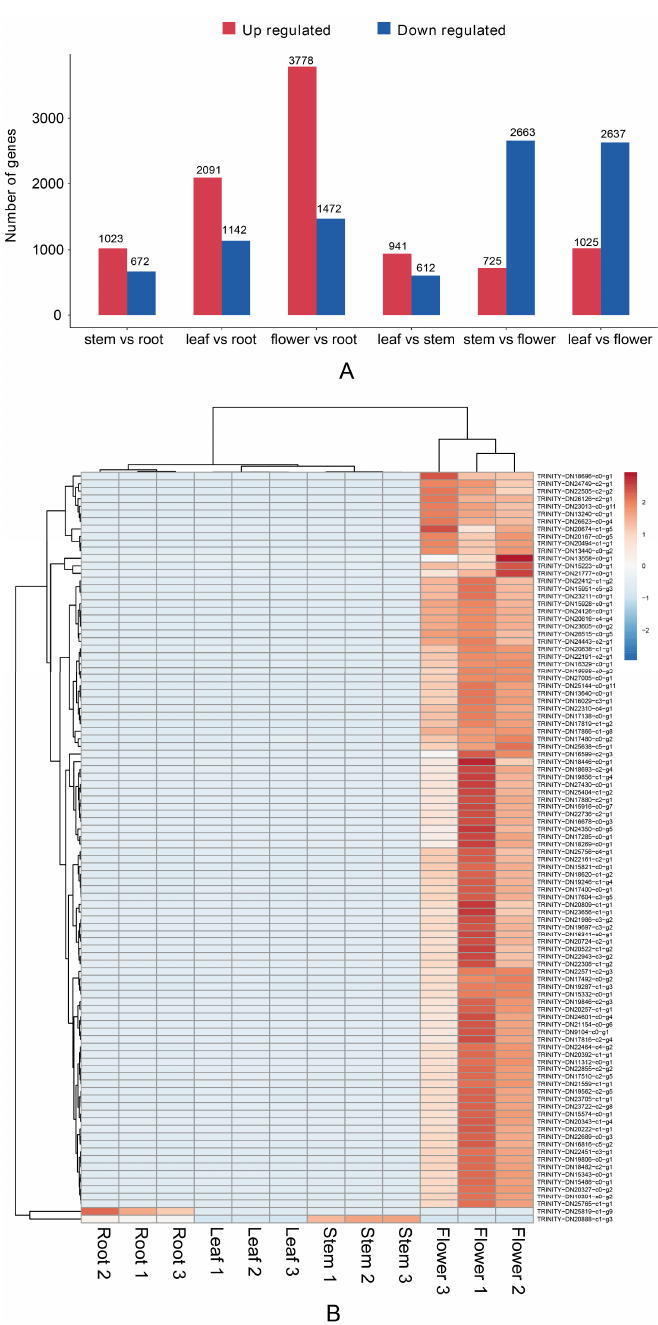
Figure 6. Expression of differential unigenes in G. macrophylla : ( A ) A summary upregulated and downregulated unigenes between sets of two specified samples. ( B ) Heatmap of differentially expressed genes from different tissues. Each column in the figure represents one sample, while each row represents one gene. The colors indicate the normalized gene expression levels (log10 (TPM+1)) in different tissues. Red and blue represent high and low expression levels, respectively.